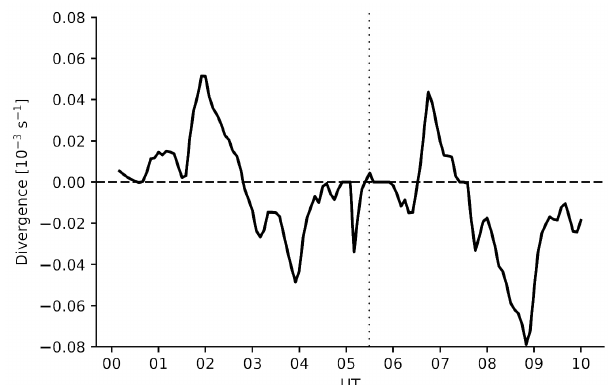
Figure 7. Average divergence calculated for the wind field present in Fig. 6. Period of divergence followed by convergence that coin- cide with both MTM peaks. The vertical line represents the local midnight in average longitude of the NATION network.